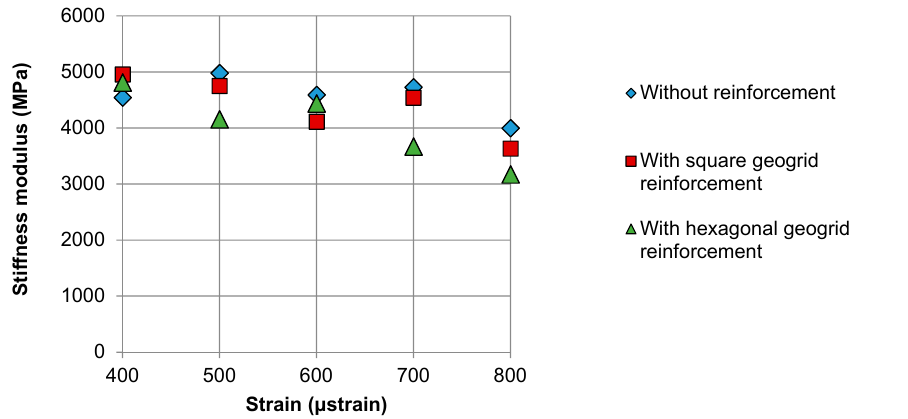
15 of 24 Figure 7. Shearing strength ( a ) and shearing stiffness ( b ) of systems without reinforcement, with hexagonal geogrid and with square aperture geogrid reinforcement. 4.2. Flexural Stiffness of Double-Layered Systems with and Without Reinforcement Figure 8 presents the influence of test load frequency on the stiffness modulus of the systems. The analysis of frequency was performed at the controlled strain mode of 100 μ strain after 100 conditioning cycles. The low level of strain was chosen to minimise the accumulation of fatigue damage in specimens during the stiffness modulus test. Figure 8. Comparison of the initial stiffness obtained at different load frequencies for double-lay- ered asphalt concrete beams reinforced with square and hexagonal geogrids, as well as for refer- ence samples without reinforcement. For both types of geogrid composites, the initial stiffness of reinforced specimens was lower by 13% to 26% in comparison with specimens without reinforcement. This behav- iour was likely due to the presence of a relatively thick layer of bitumen-soaked fabric between the asphalt layers, which acted as a stress relief membrane and thus reduced the inter-layer bonding. Figure 9 shows the S ini initial stiffness of the systems determined at various strain levels and with 1 Hz test frequency. Since the initial stiffness was measured during the